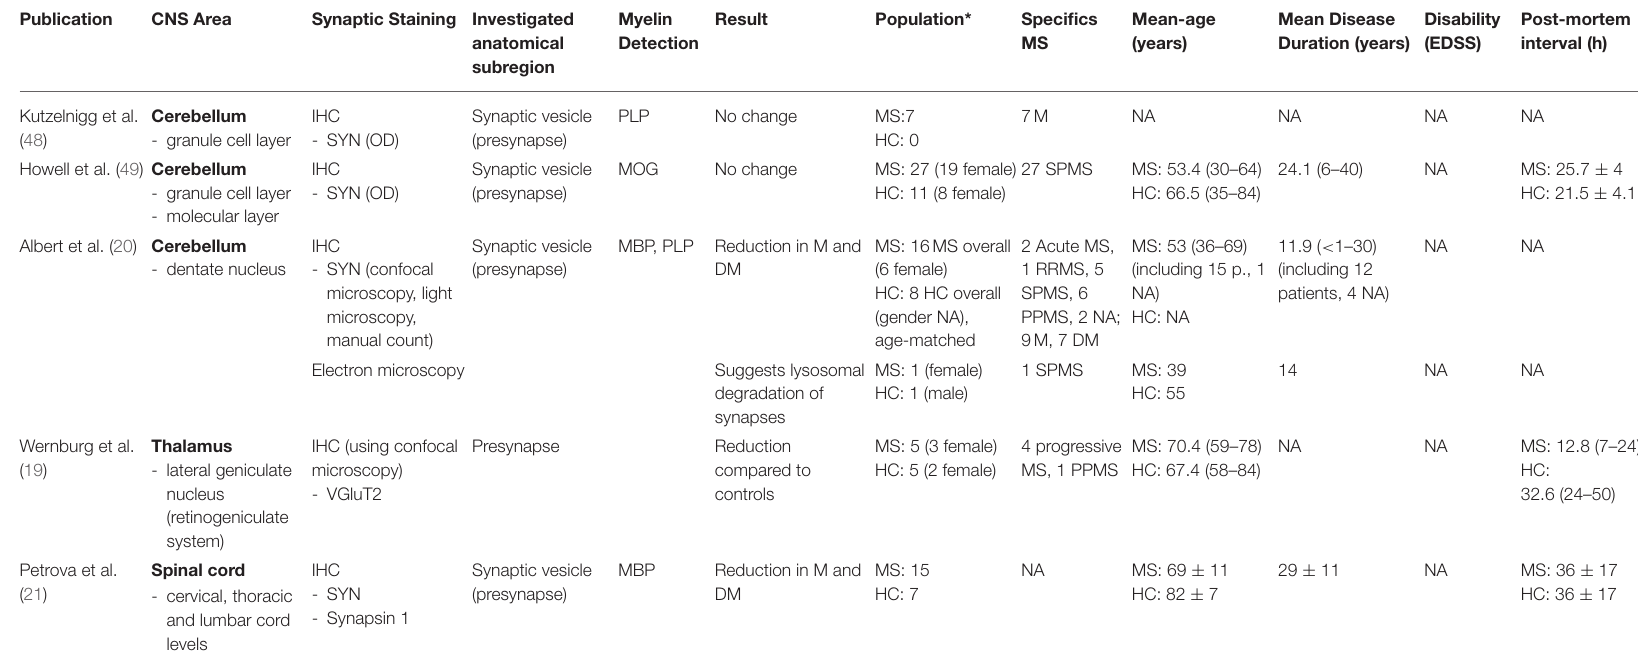
TABLE 4 | An overview of publications that investigated the synaptic density in the cerebellum, the thalamus, and in the spinal cord, along with extracted